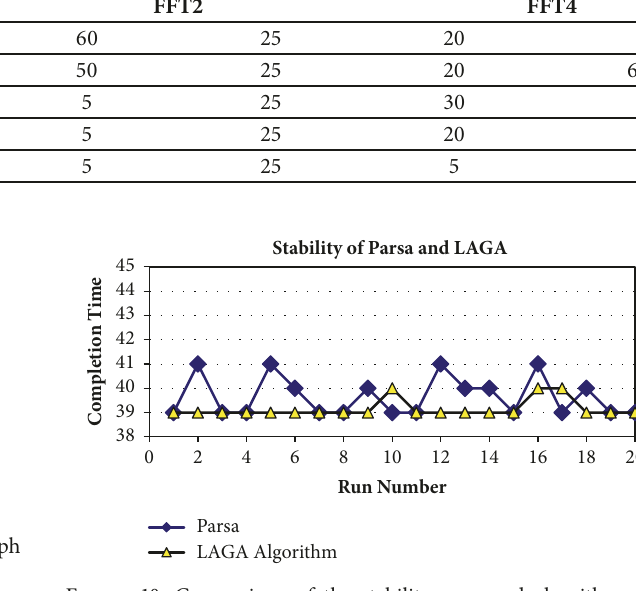
Figure 10: Comparison of the stability proposed algorithm and Parsa